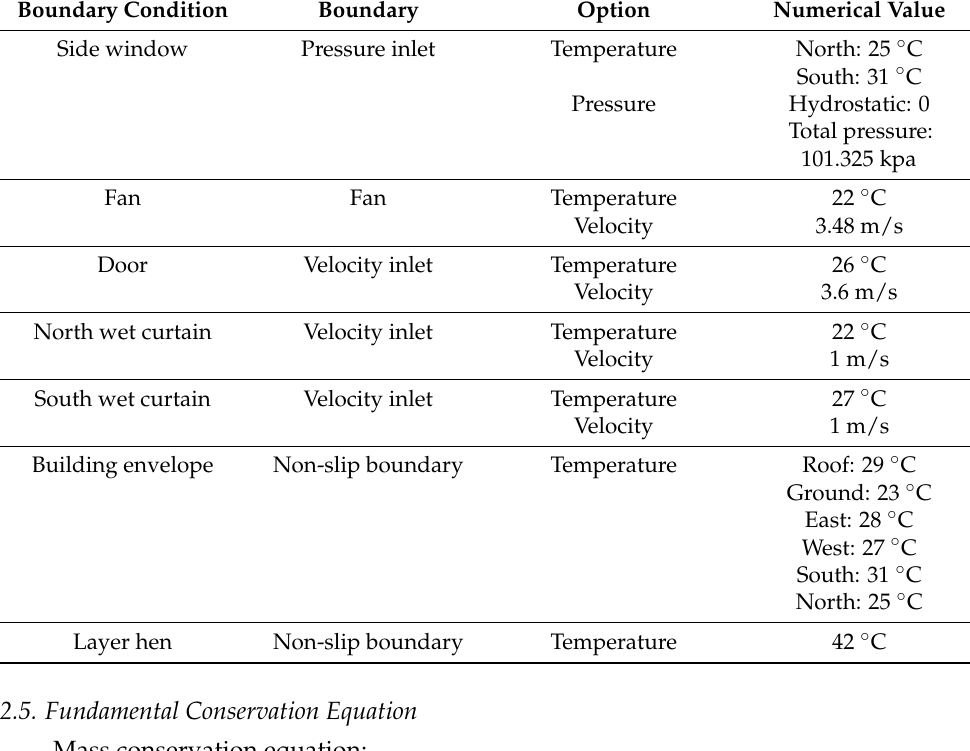
Table 1. Boundary condition